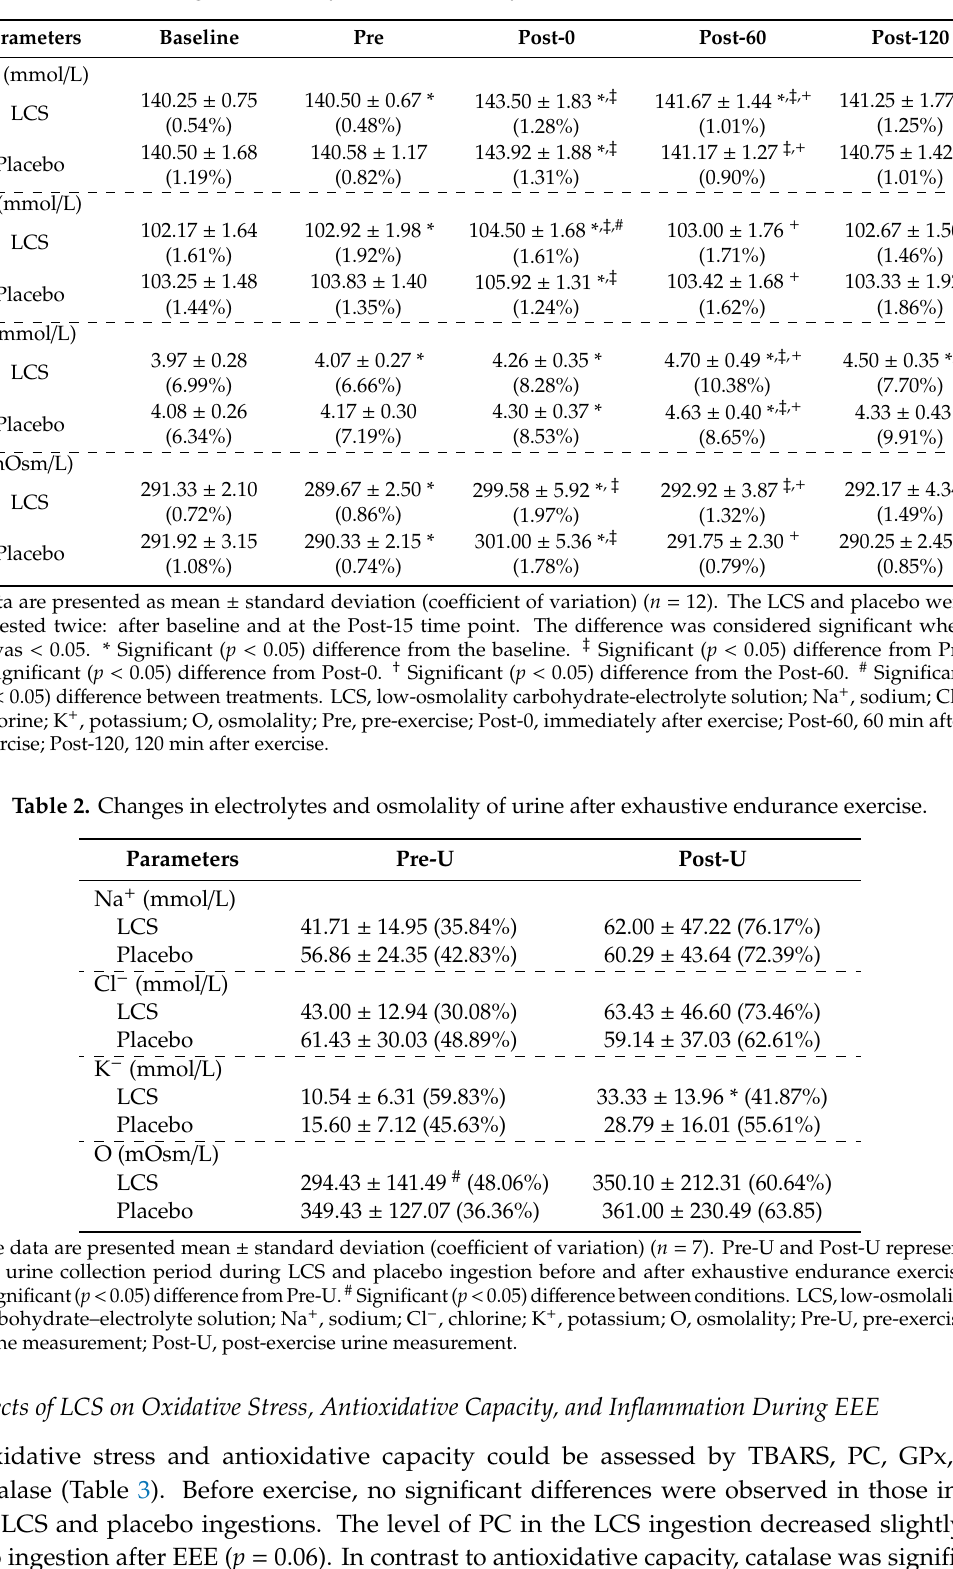
Table 1. Changes in electrolytes and osmolality after exhaustive endurance exercise.